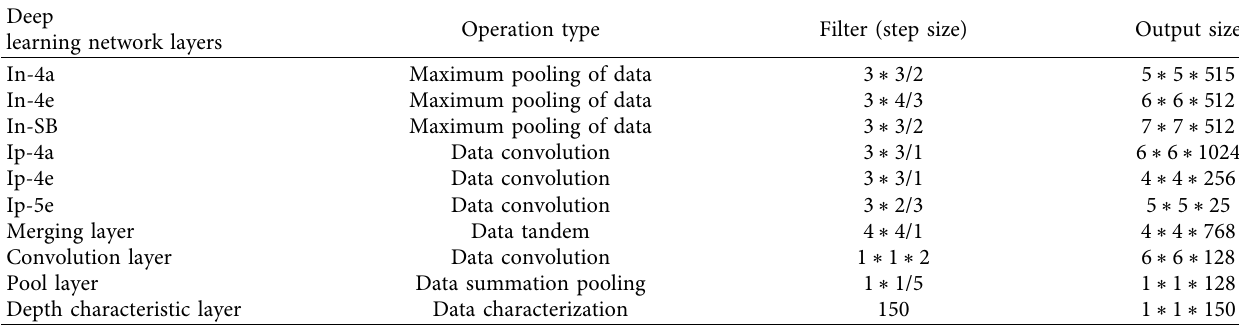
Table 2: Related parameters of the deep learning network layer in multimedia data processing.